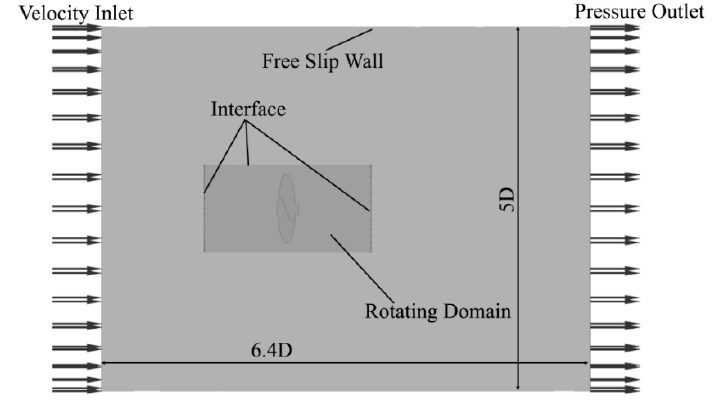
Figure 12. Computation domain of E779A.